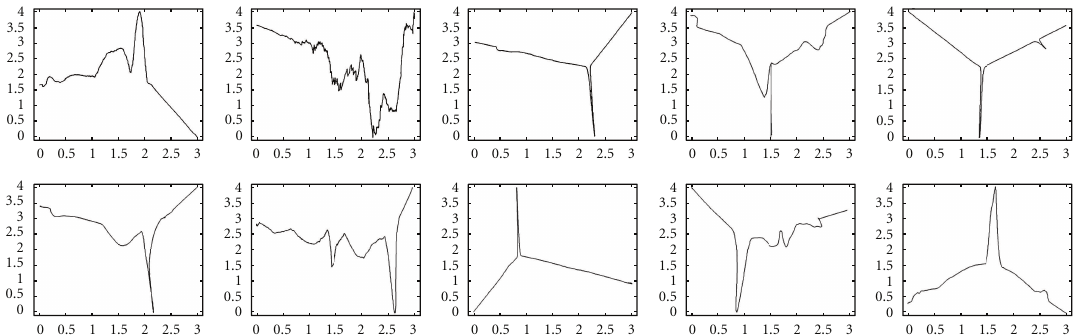
Figure 14: Motion models in the latent space using the modified ISOMAP algorithm.